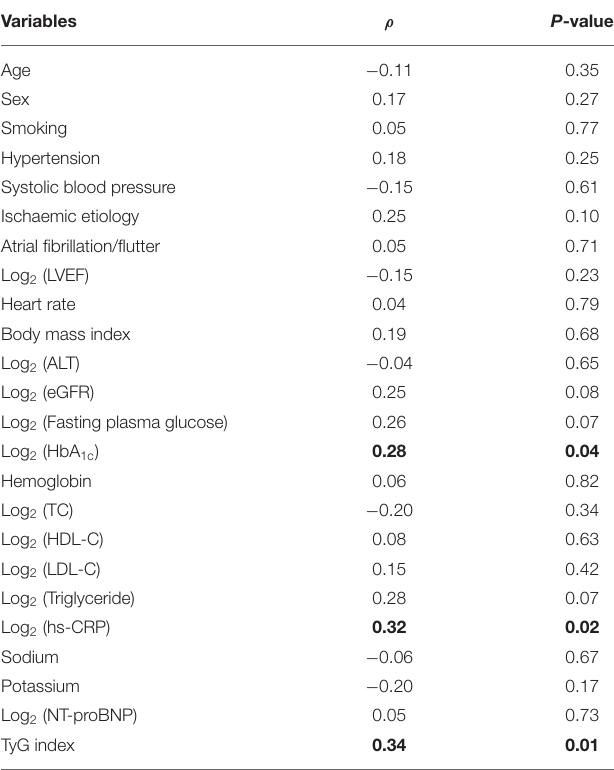
TABLE 2 | Association between clinical variables and ECV fraction in HF patients.